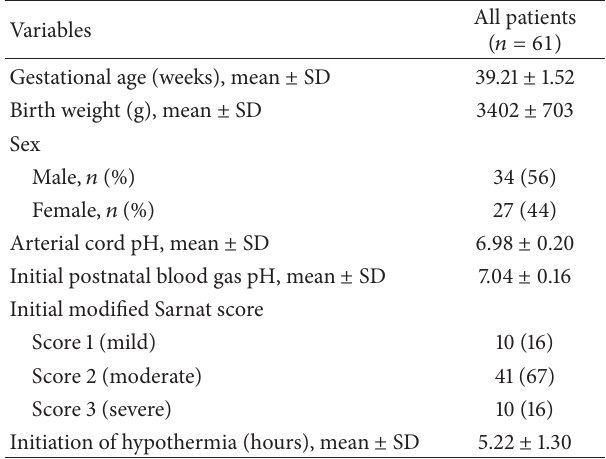
Table1:Clinicalcharacteristicsoftheasphyxiatednewbornstreated with